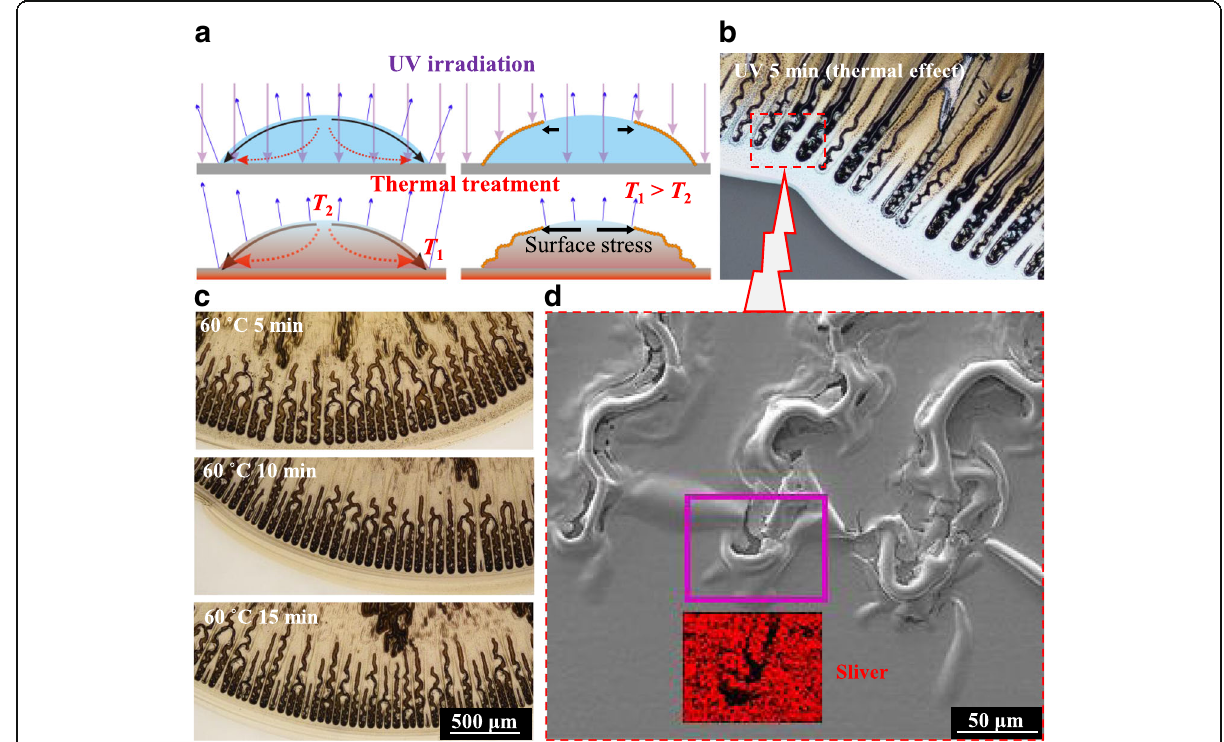
Fig. 2 Zigzag hollow cracks. a Schematic of the difference between UV irradiation and thermal treatment for the forming of surface nanoparticle film. b Zigzag-shaped ripples obtained with UV irradiation for 5 min. c More regular ripples obtained at a heated glass substrate at 60 °C for 5